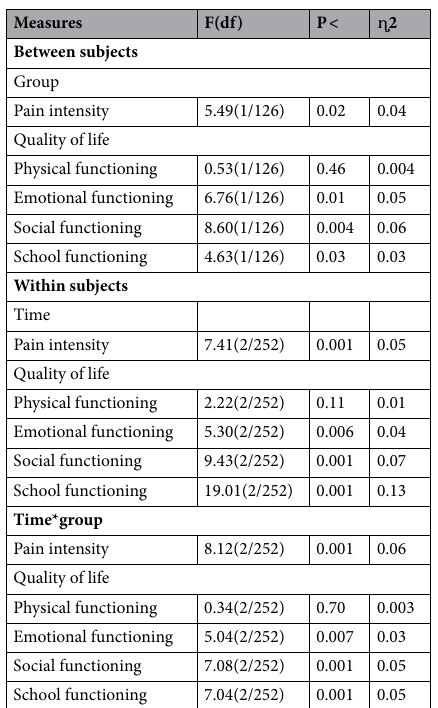
Table 3. One-way repeated measures ANOVAs, F-ratios, p values, and partial ɳ 2 .